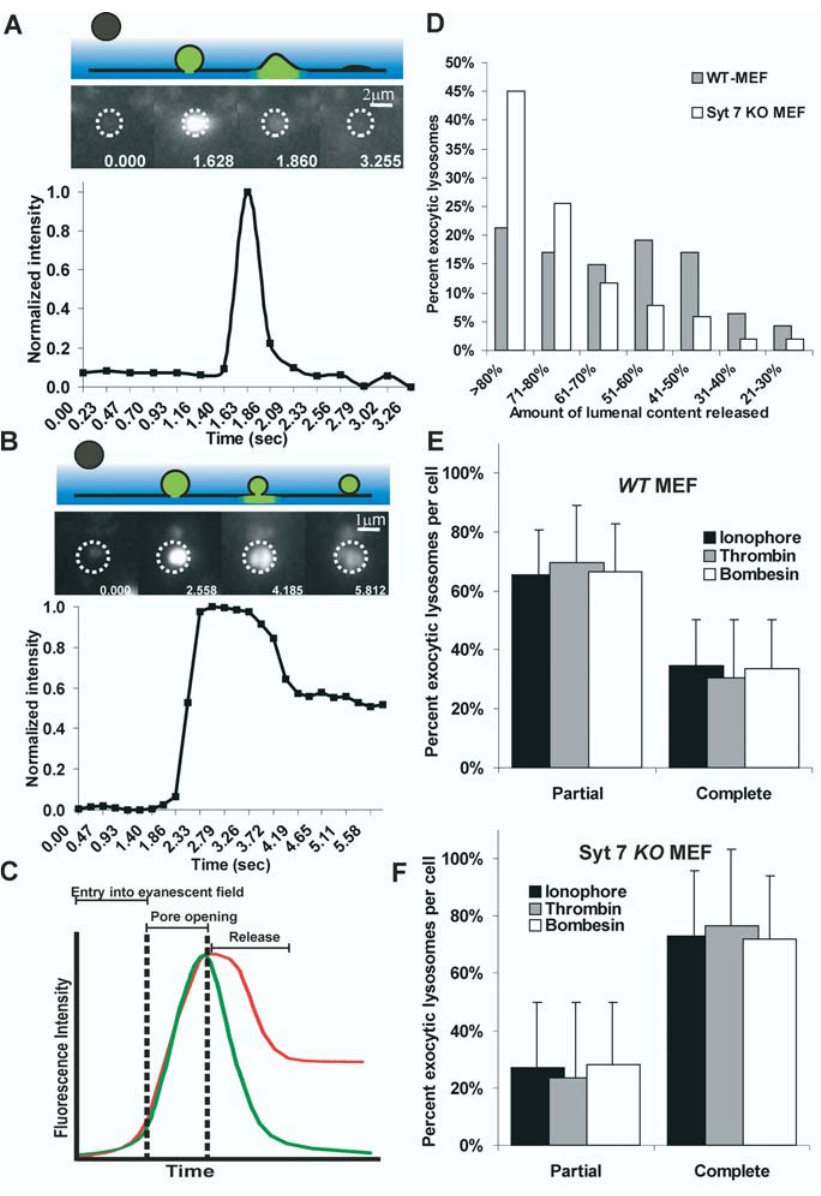
Figure 1. Fate of Lumenal Content during Lysosomal Fusion MEFs were incubated for 2 h with 70 kDa FITC–dextran followed by more than 3 h in dextran-free media to chase the dextrans into the lysosomes. These cells were then treated with calcium iono- phore (A23187) to trigger exocytosis of lysosomes. (A and B) The middle panels are images of lyosomes undergoing complete (A) and partial (B) exocytosis. Intensity plots for the regions in these images marked by dotted circles are shown in the lower panel. The top panel shows a schematic representation of these different stages. (C) Schematic fluorescence intensity plots for lysosomes undergoing partial (red) or complete (green) fusion. Owing to the exponential decay of the evanes- cent field (blue; top panels in [A] and [B]) away from the coverslip, a lysosome that is more than 150 nm from the cell membrane (black line in top panels in [A] and [B]) is not fluorescent. As this lysosome moves closer (labeled as ‘‘ entry into evanescent field ’’ ), its fluorescence intensity increases. Since the lumen of lysosome is acidic, it quenches FITC fluorescence. As soon as the fusion pore is formed, the lysosomal lumen is rapidly alkalinized resulting in an increase of FITC–dextran fluorescence ( ‘‘ pore open- ing ’’ ). Following the pore opening, the dextran is released and it diffuses away from the site of the fusion, causing the lumenal fluorescence to decrease ( ‘‘ re- lease ’’ ). (D) A histogram of the fraction of lumenal contents released by exocytos- ing lysosomes. Upon ionophore-trig- gered fusion, 21% of all lysosomes analyzed in WT MEFs ( n = 47; gray bars) and 45% of all in Syt VII KO MEFs ( n = 51; white bars) completely released their lumenal content. (E and F) To monitor the nature of lysosomal fusion in individual WT MEFs (E) and Syt VII KO MEFs (F), calcium was increased using ionophore ( WT , n = 7 cells; KO , n = 9 cells) as well as the IP3 agonists bombesin ( WT , n = 6 cells; KO , n = 9 cells) and thrombin ( WT , n = 5 cells; KO , n = 7 cells). Irrespective of the means, increase in calcium led to most lysosomes to fuse partially in WT MEFs (E) and completely in Syt VII KO MEFs (F). The error bars represent SEM. DOI: